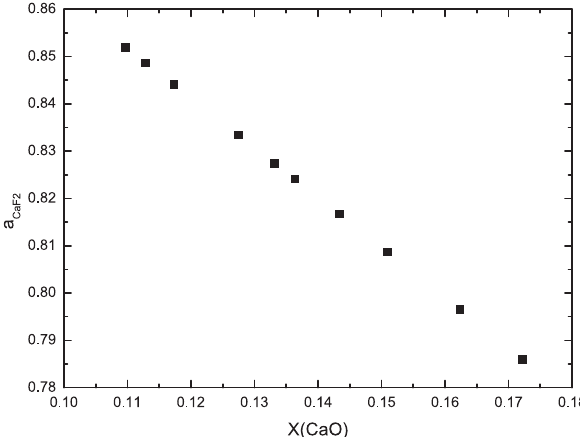
Fig. 2: Calculated activity of CaF 2 (with solid CaF 2 as standard state) at 1723 K in CaO-CaF 2 system